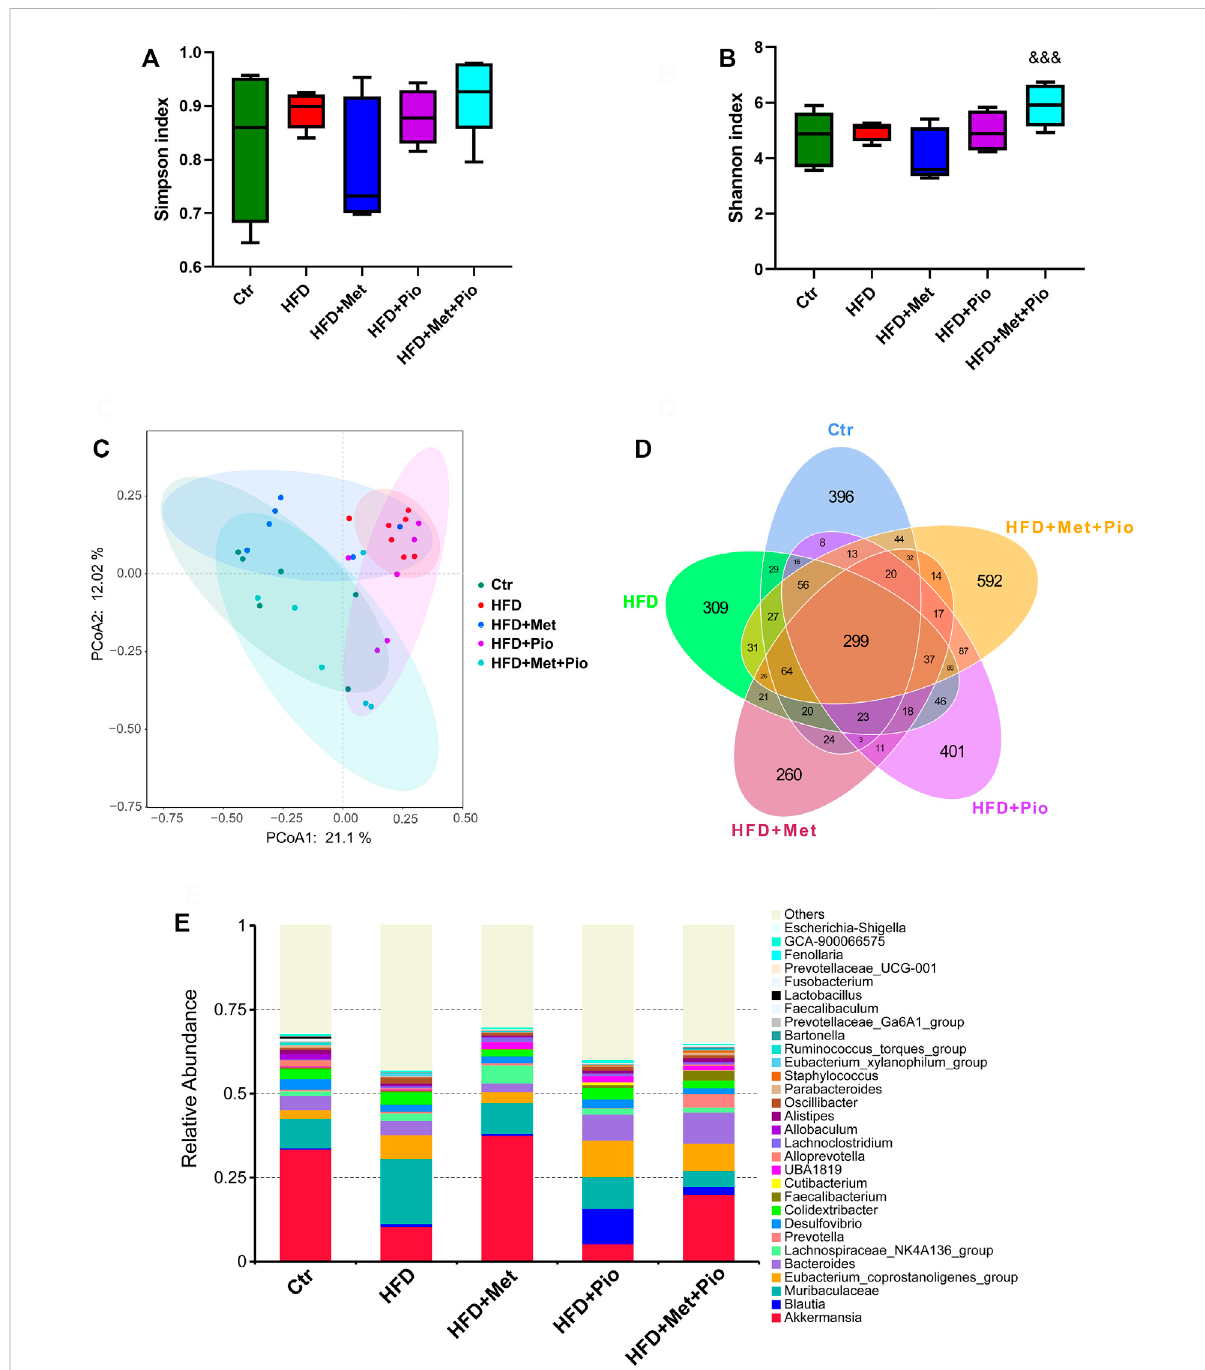
FIGURE 2 Combination therapy of metformin and pioglitazone on gut microbiota diversity. (A) Shannon index; (B) Simpson index; (C) PCoA plots of gut microbiome; (D) Venn diagram of the ASVs; (E) Relative abundance of the top 30 species at the genus level. Ctr, standard control diet; HFD, high-fat diet; HFD+Met, high-fat diet treated with metformin; HFD+Pio, high-fat diet treated with pioglitazone; HFD+Met+Pio, high-fat diet treated with metforminandpioglitazone.Dataareexpressedasthemeans±SDs. ( n =6 – 7/group).One-wayANOVA;* p < 0.05,** p < 0.01,*** p < 0.001HFD versus Ctr group; # p < 0.05, ## p < 0.01, ### p < 0.001 HFD+Met group versus HFD group, HFD+Piogroup versus HFD group, or HFD+Met+Pio group versus HFD group; & p < 0.05, and& p < 0.01, andand& p < 0.001 HFD+Pio group versus HFD+Met group, or HFD+Met+Pio group versus HFD+Met group; $ p < 0.05, $$ p < 0.01, $$$ p < 0.001 HFD+Met+Pio group versus HFD+Pio